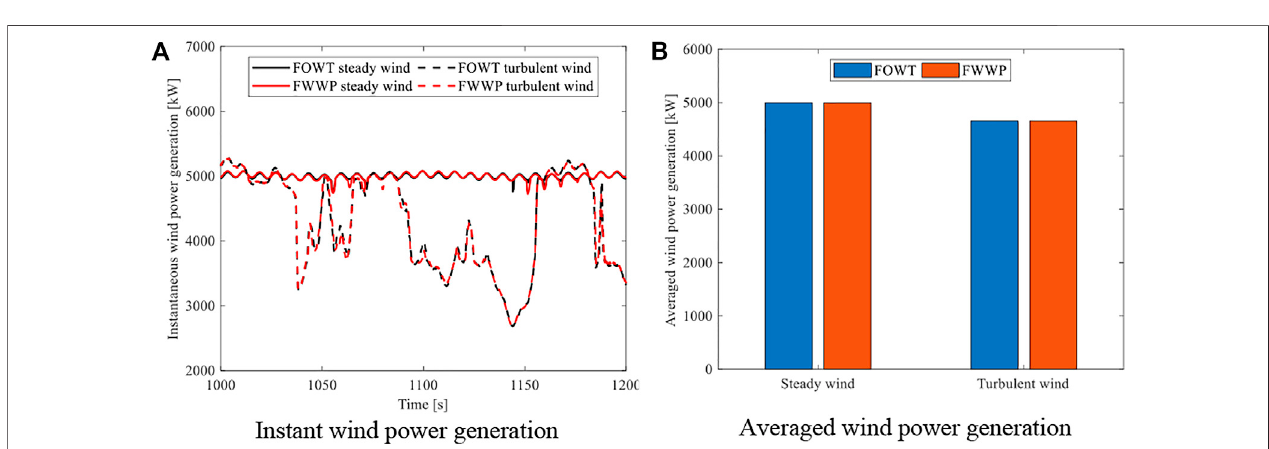
FIGURE 13 | Wind power generation in the FOWT and FWWP. (A) Instant wind power generation. (B) Averaged wind power generation.